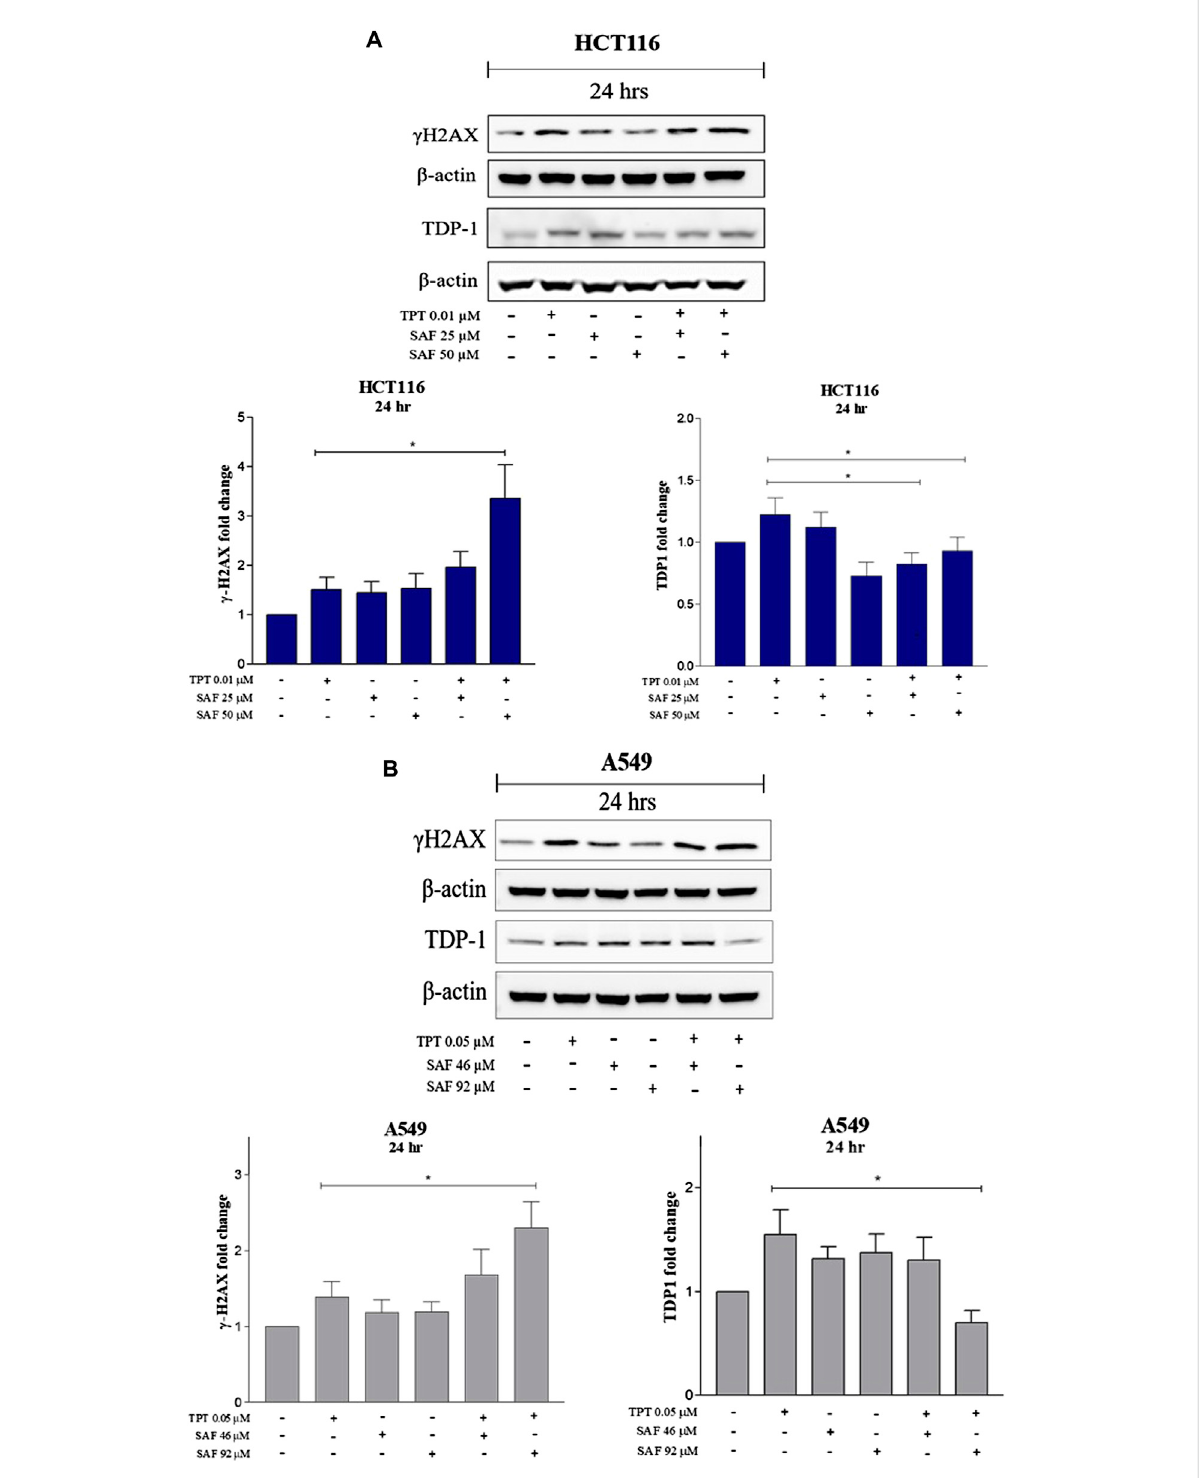
FIGURE 3 Expression of γ H2AX and TDP1 in HCT116 and A549 cells after treatment with SAF IC25/IC50 before TPT IC50 treatment Western blot analysis for HCT116 (A) and A549 (B) was performed by loading the whole cell lysates treated with SAF IC25/IC50 before TPT 0.01 µM for 24 and 48 h in HCT116cellsandtreatedwithSAFIC25/IC50beforeTPT0.05 µMfor24and48 hinA549cells.Bargraphsrepresentdensitometricquanti fi cationsof Western blotbands normalized to β -actinand vehicle-treated control. The means ± SEM of atleast three independent experiments are shown. * p < 0.05 vs. TPT